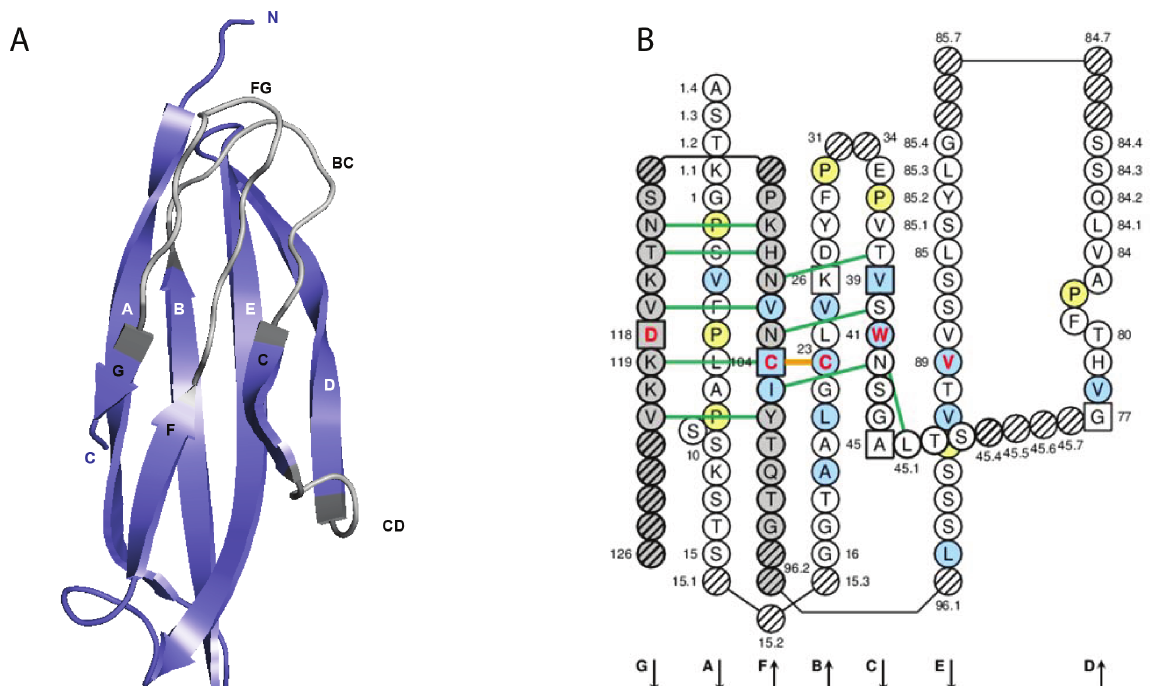
Figure 4. Constant (C) domain. An IG CH (C-DOMAIN) is shown as example. ( A ) 3D structure ribbon representation with the IMGT strand and loop delimitations [63]; (B) IMGT Collier de Perles on two layers with hydrogen bonds. The IMGT Colliers de Perles on two layers show, in the forefront, the GFC strands and, in the back, the ABED strands (located at the interface CH1/CL of the IG), linked by the CD transversal strand. The IMGT Collier de Perles with hydrogen bonds (green lines online, only shown here for the GFC sheet) is generated by the IMGT/Collier-de-Perles tool integrated in IMGT/3Dstructure-DB, from experimental 3D structure data [9–11]; ( C ) IMGT Collier de Perles on two layers from IMGT/DomainGapAlign [10,25,26]; ( D ) IMGT Colliers de Perles on one layer. Amino acids are shown in the one-letter abbreviation. All proline (P) are shown online in yellow. IMGT anchors are in square. Hatched circles are IMGT gaps according to the IMGT unique numbering for C domain [63,65]. Positions with bold (online red) letters indicate the four conserved positions that are common to a V domain and to a C domain: 23 (1st-CYS), 41 (CONSERVED-TRP), 89 (hydrophobic), 104 (2nd-CYS) [60–63,65] (Table 3), and position 118 which is only conserved in V-DOMAIN. The identifier of the chain to which the CH domain belongs is 1n0x_H (from the Homo sapiens b12 Fab, in IMGT/3Dstructure-DB, [1]). The 3D ribbon representation was obtained using PyMOL and “IMGT numbering comparison” of 1n0x_H (CH1) from IMGT/3Dstructure-DB